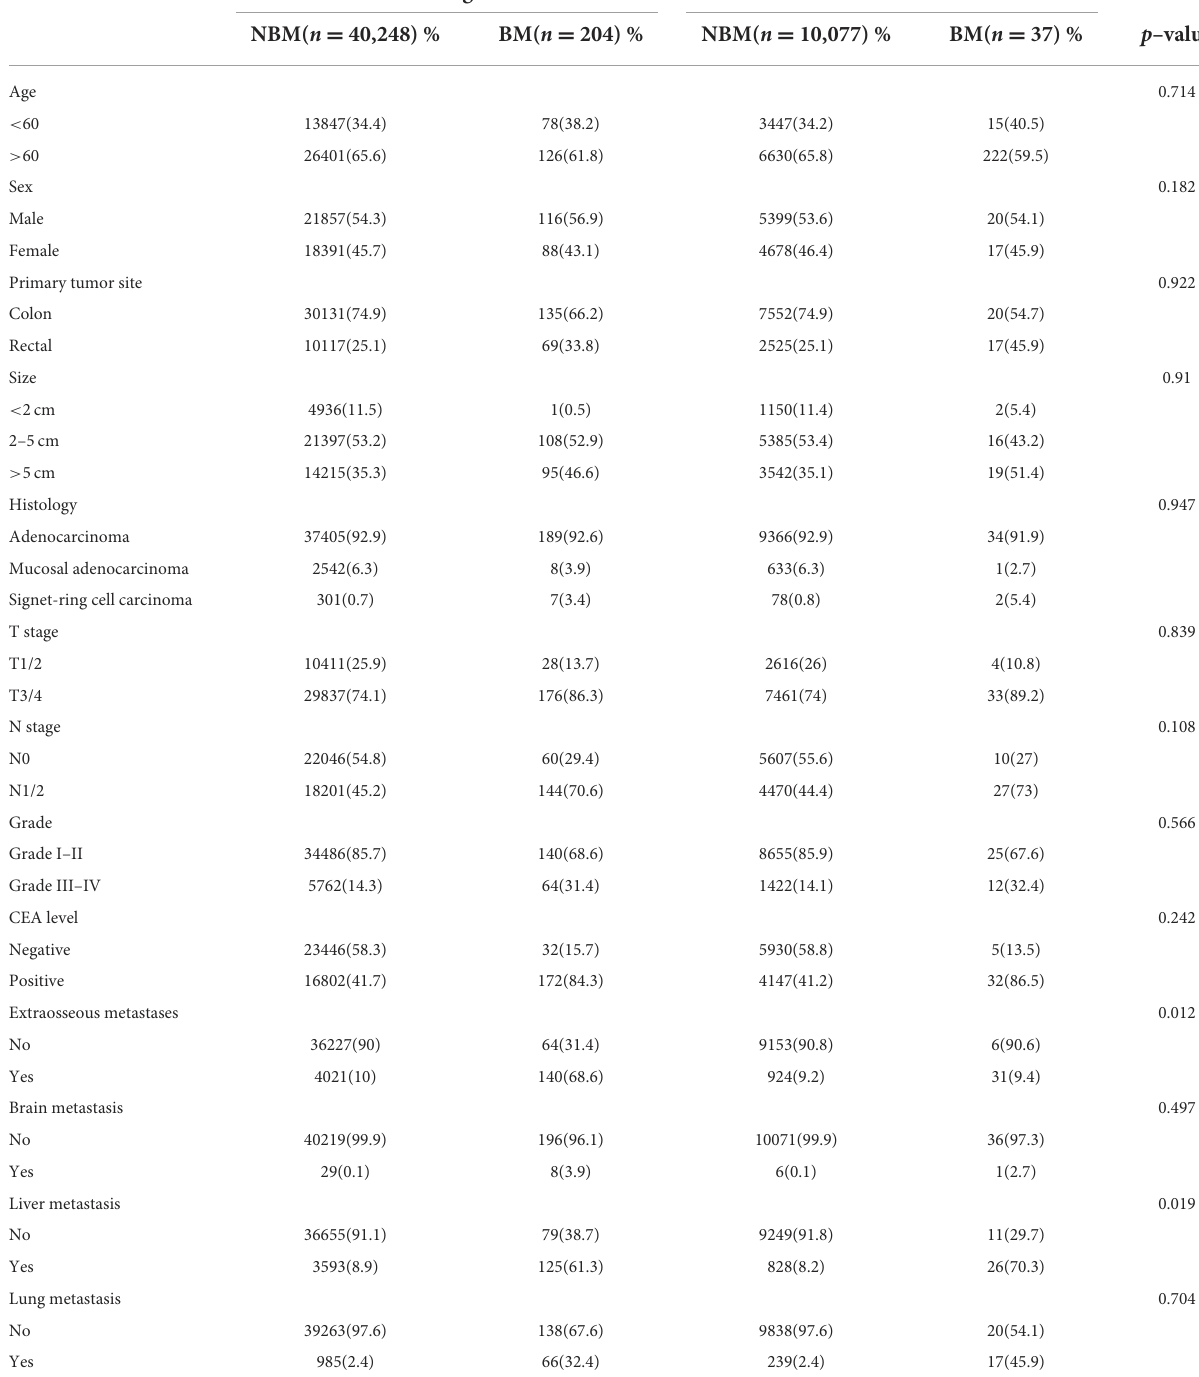
TABLE 1 Clinical and pathological characteristics of training and test